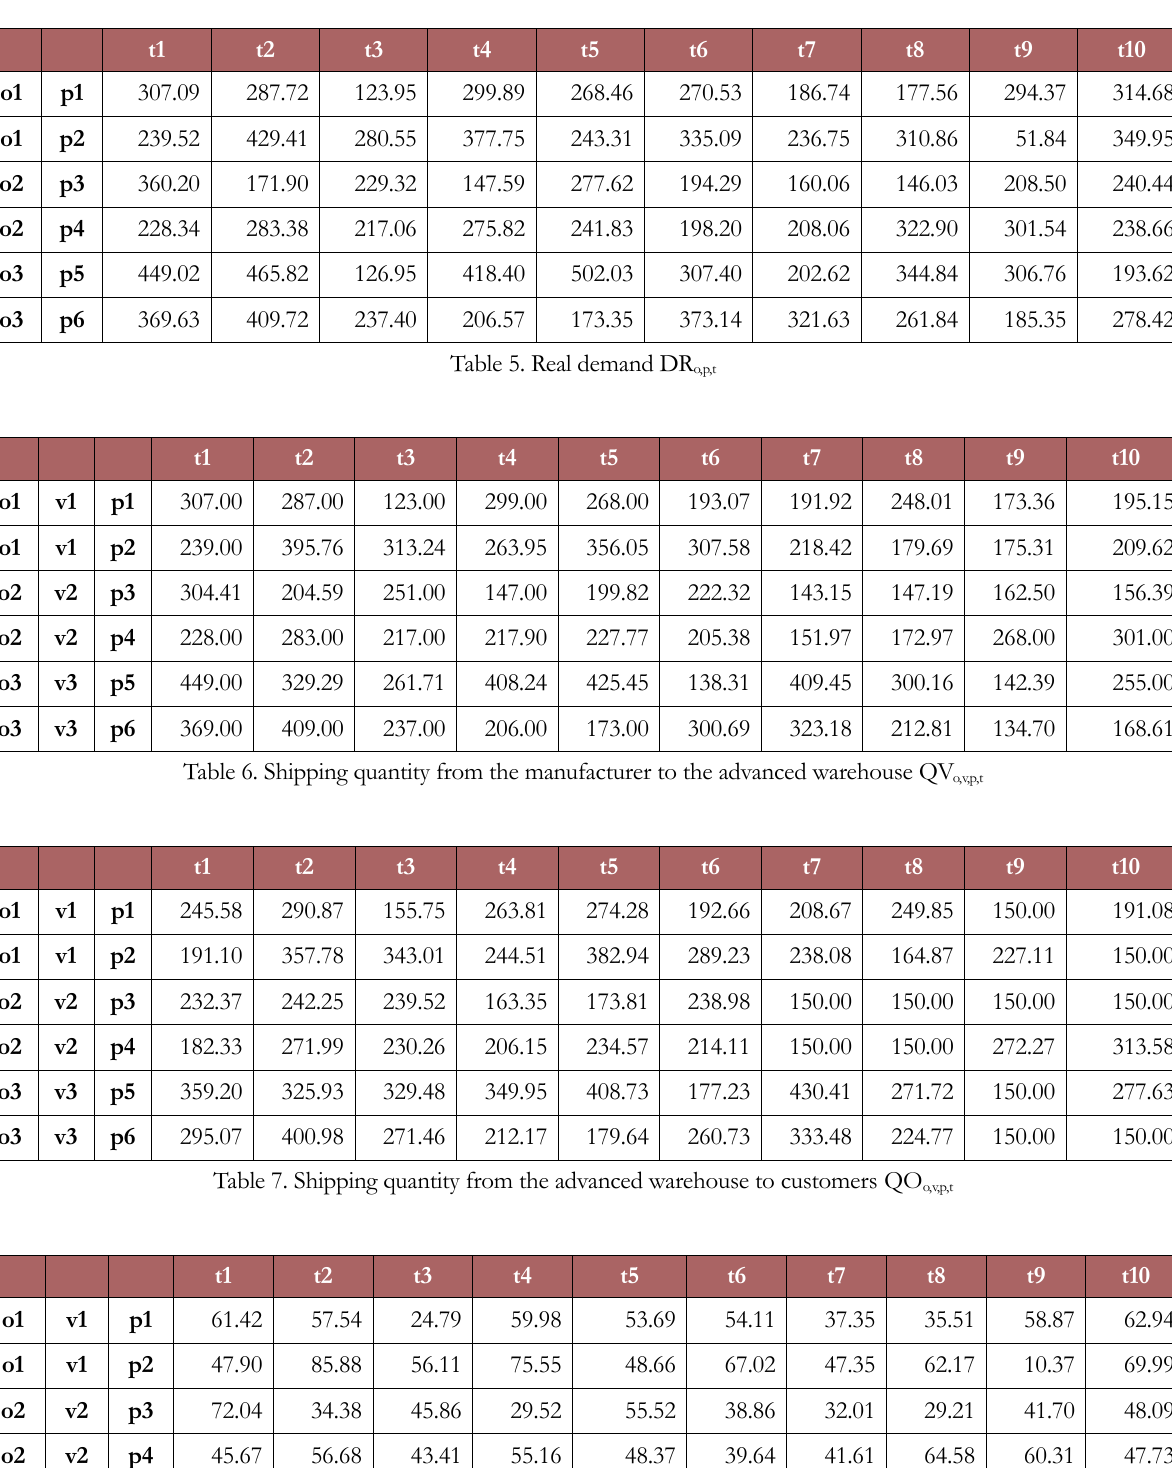
Table 8. Product inventory level at the advanced warehouse IPV